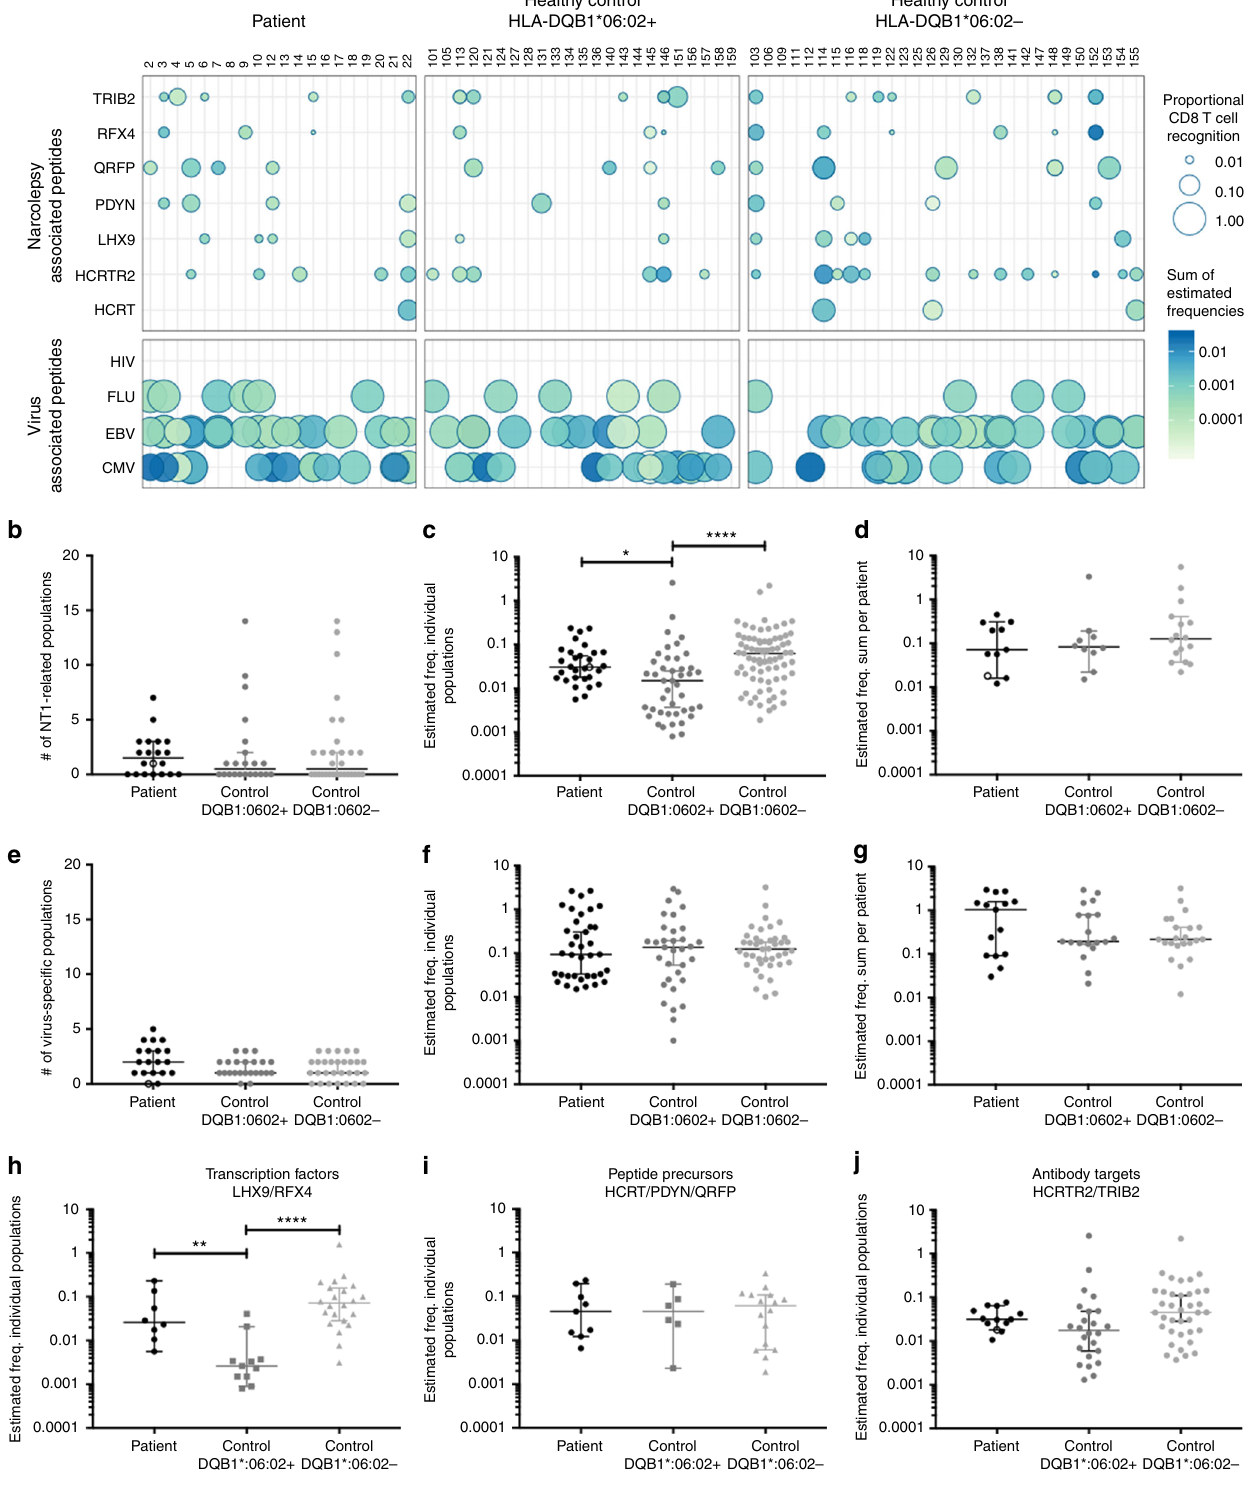
Although T-cell recognition was observed in all three cohorts both toward NT-relevant and virus-derived epitopes, comparison between the three different groups did reveal some interesting immunological characteristics for the NT1-related CD8 + T-cell recognition. When counting the number of different peptide- speci fi c CD8 + T-cell populations found in each donor in the different cohorts, NT1 patients, HLA-DQB1*06:02-positive